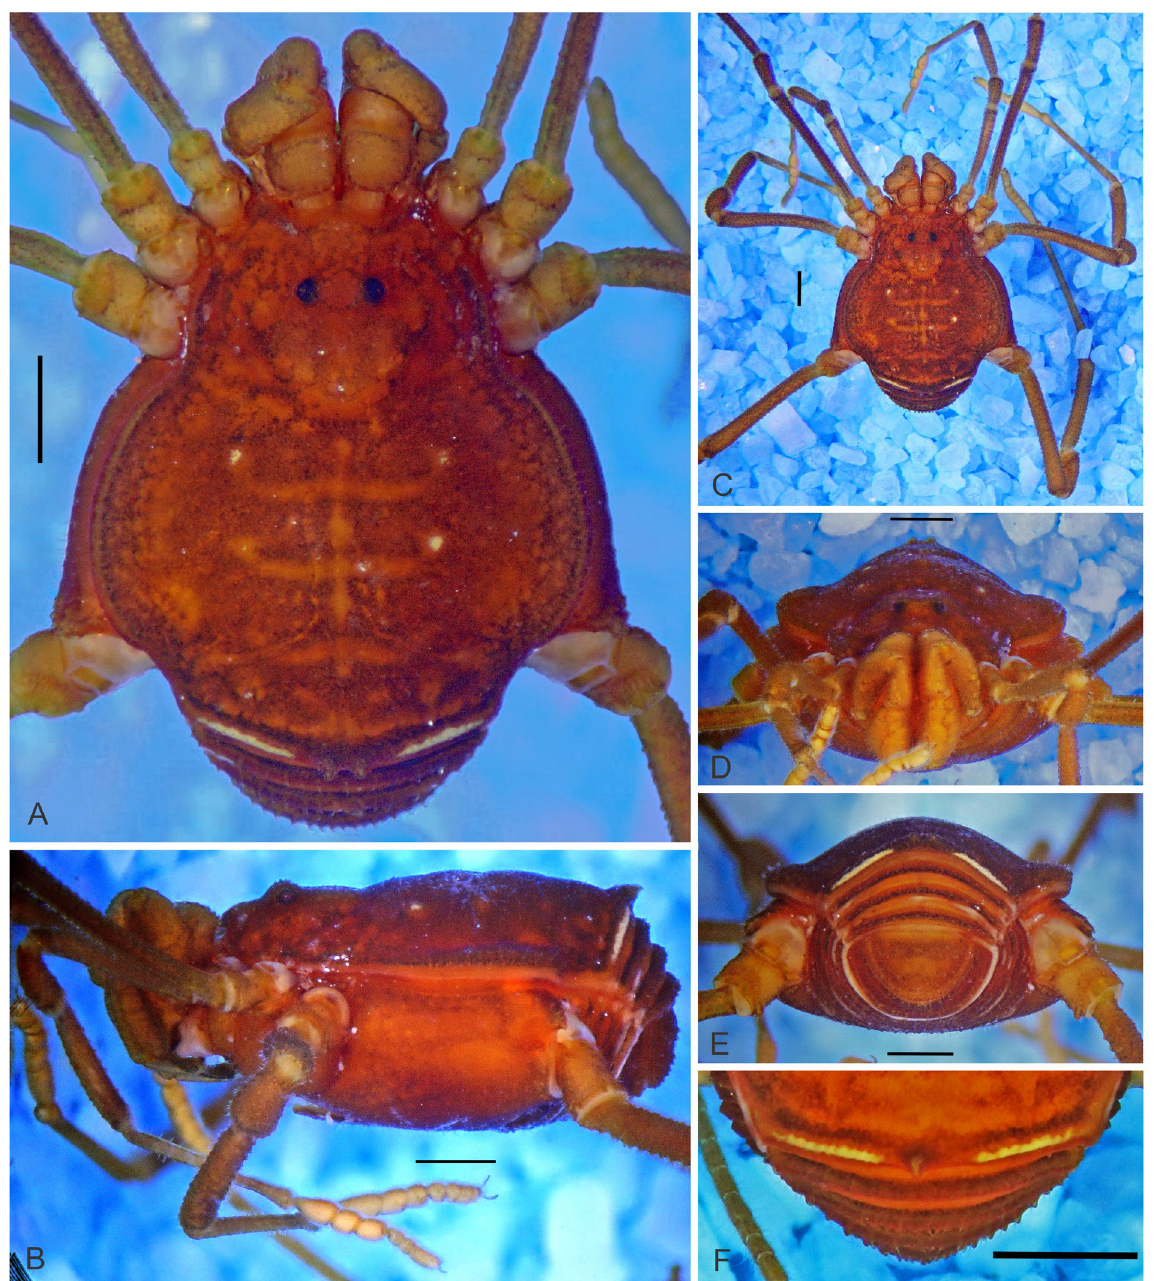
Fig. 23. Eulibitia pollux sp. nov., ♂, paratype (MNRJ 19369), habitus. A . Dorsal view. B . Left lateral view. C . Panoramic, dorsal view. D . Frontal view. E . Posterior view. F . Detail of another paratype with a single spine on posterior margin of scutum. Scale bars: 1